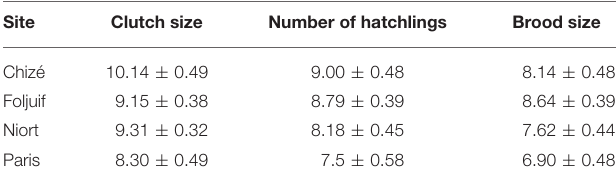
A posteriori comparison of means or lsmeans for differences among sites (see Section Materials and Methods and Results for more details on the models and site main effect) showed that clutch size in Chizé differed significantly from that in Paris (z = 2.90, adj. p = 0.004). Brood size in Foljuif differed from that in Niort and Paris (z = 2.12, adj. p = 0.03 and z = 2.77, adj. p = 0.006, respectively), and brood size in Paris differed from that in Chizé (z = 2.09 adj. p = 0.04). All other comparison were non-significant (all z < 1.35 and adj. p >